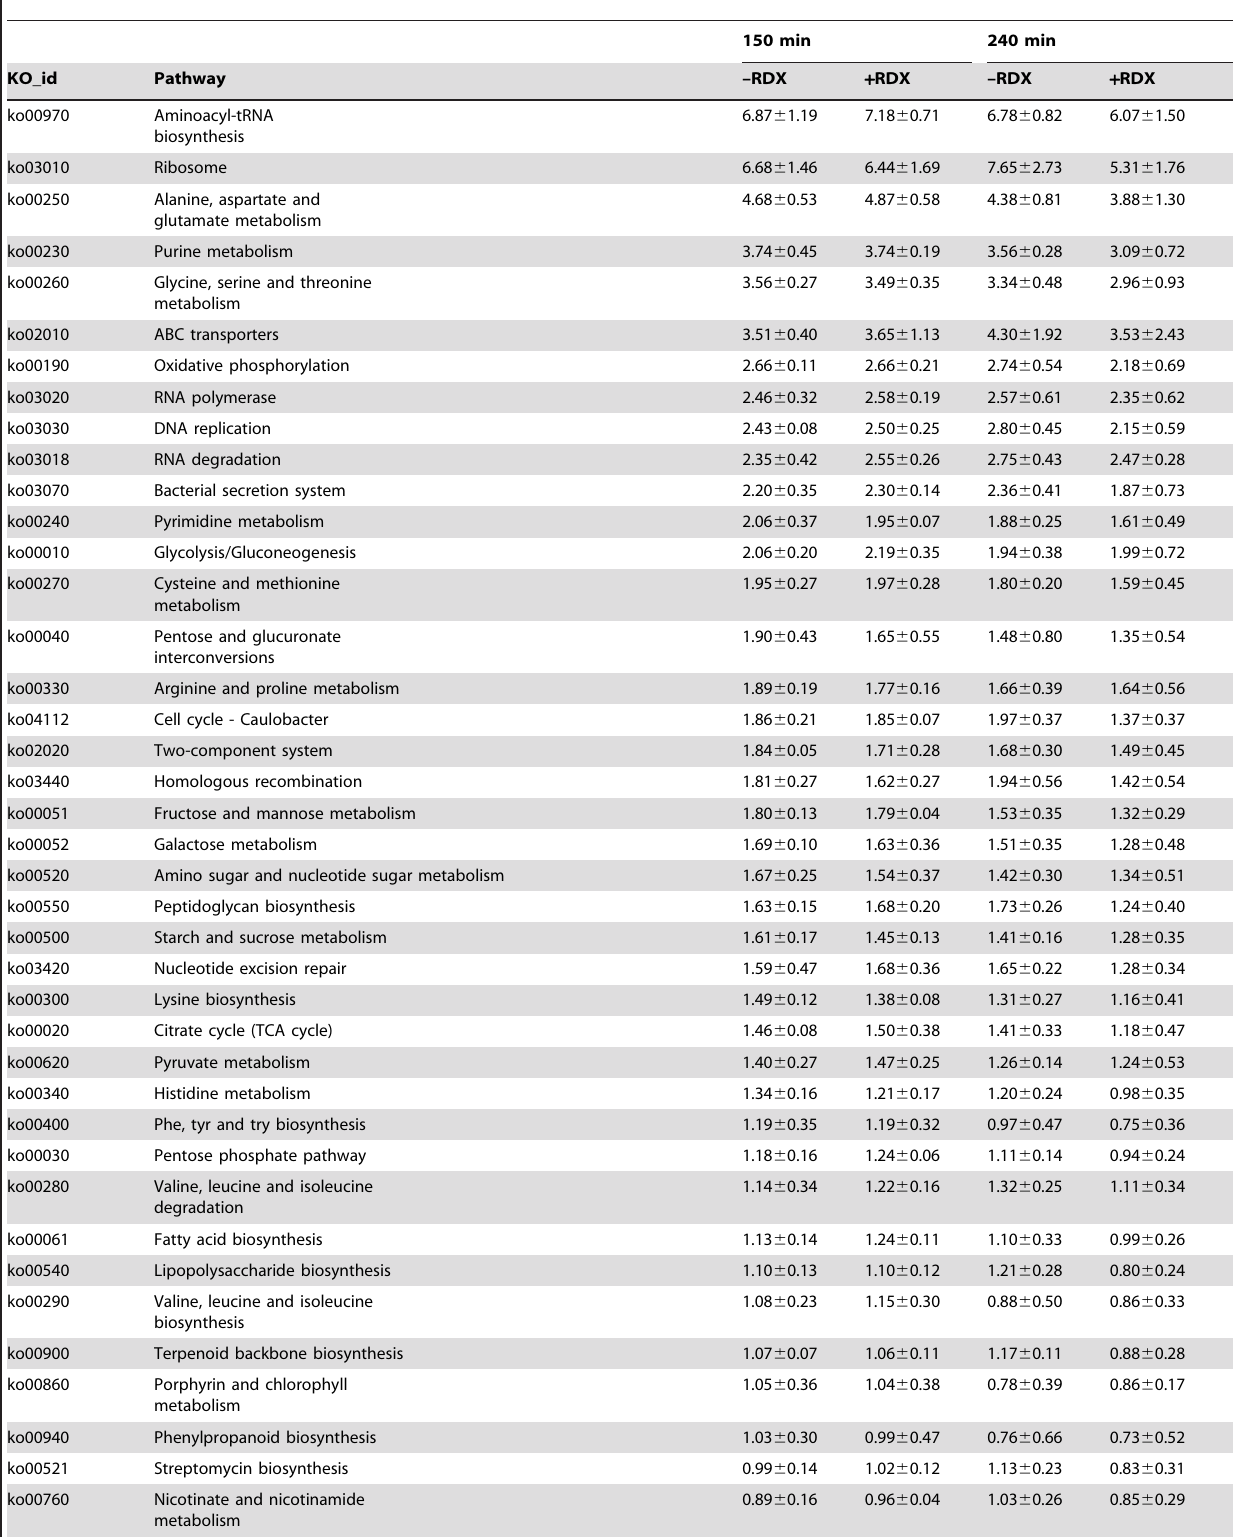
Table 3. The relative abundance of 40 KEGG Orthology (KO) pathways with ( + ) and without (–) RDX incubation in the ovine rumen.